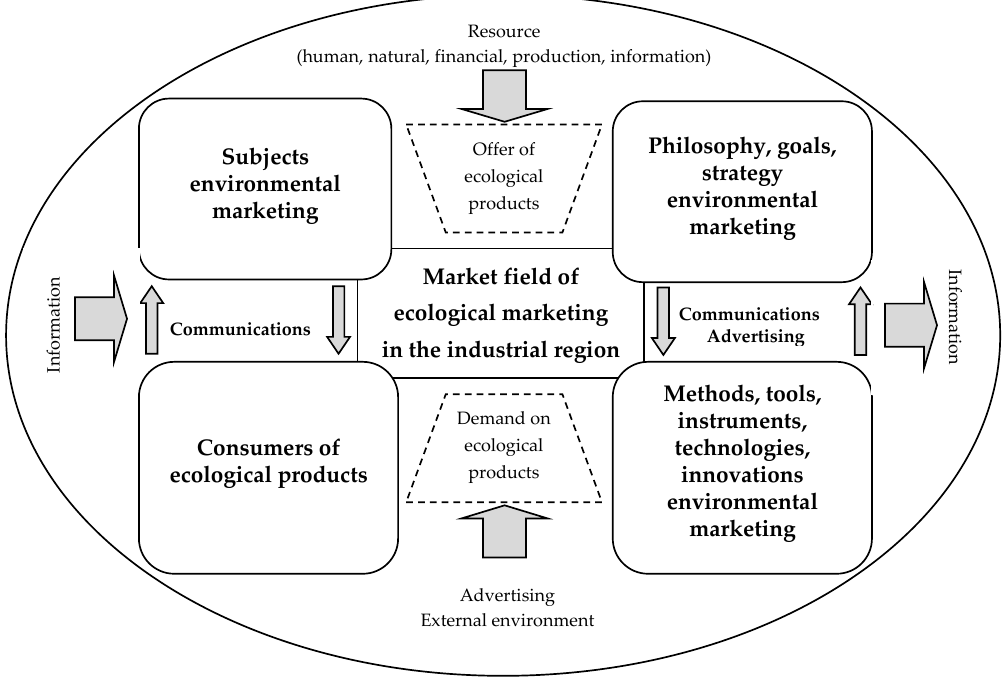
Figure 1. Market field of ecological marketing in the industrial region (the authors’ scheme).